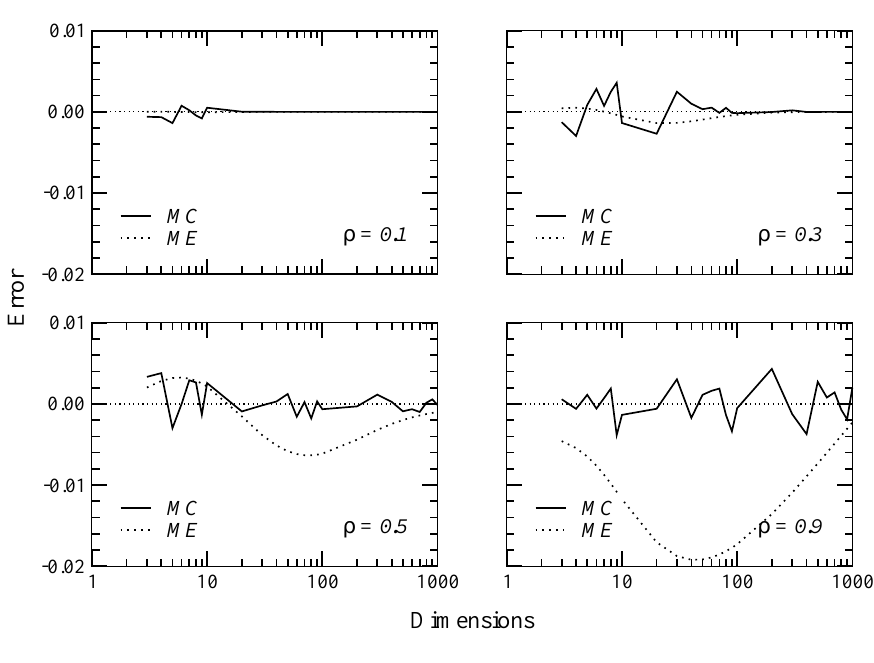
Figure 1. Estimation error in Genz Monte Carlo ( MC ) and Mendell-Elston ( ME ) approximations. ( MC only: single replication; requested accuracy (cid:101) =